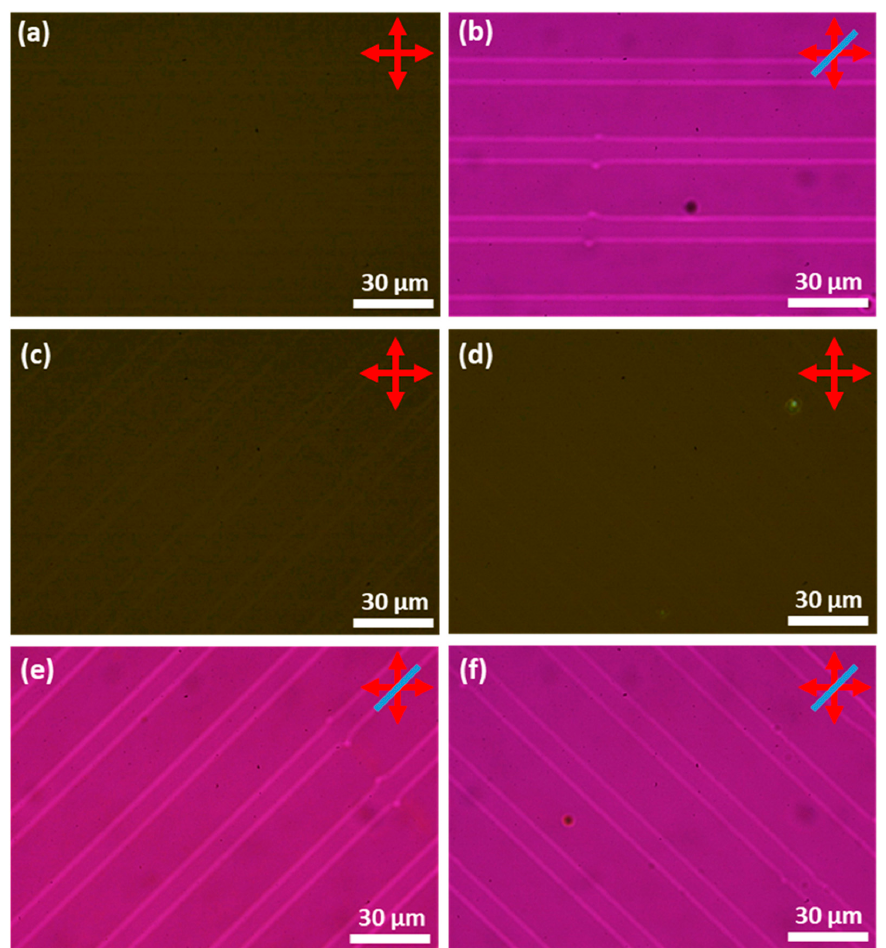
Figure 10. POM images for de ‐ wetted stripes of MLC6609. Hydrophilic stripes 30 μ m wide and hydrophobic stripes 10 μ m wide. ( a ) Crossed polarisers with the stripes parallel to one polarisation direction. ( b ) With an added lambda plate. ( c , d ) Crossed polarisers with the stripes at +45° and − 45° to the vertical. ( e , f ) With an added wave plate. The blue line indicates the orientation of the slow axis of the compensator.